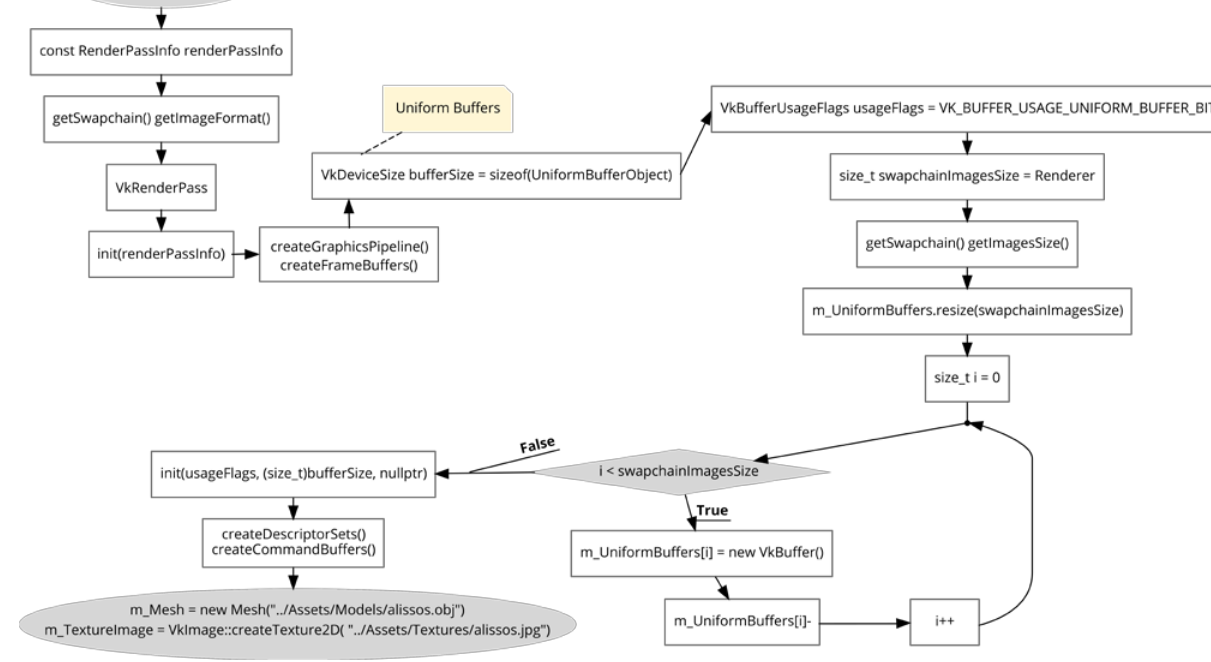
Figure 1. Initialization of render pass commands in the secondary command buffer where the drawing objects (m_Mesh and m_TextureImage) are